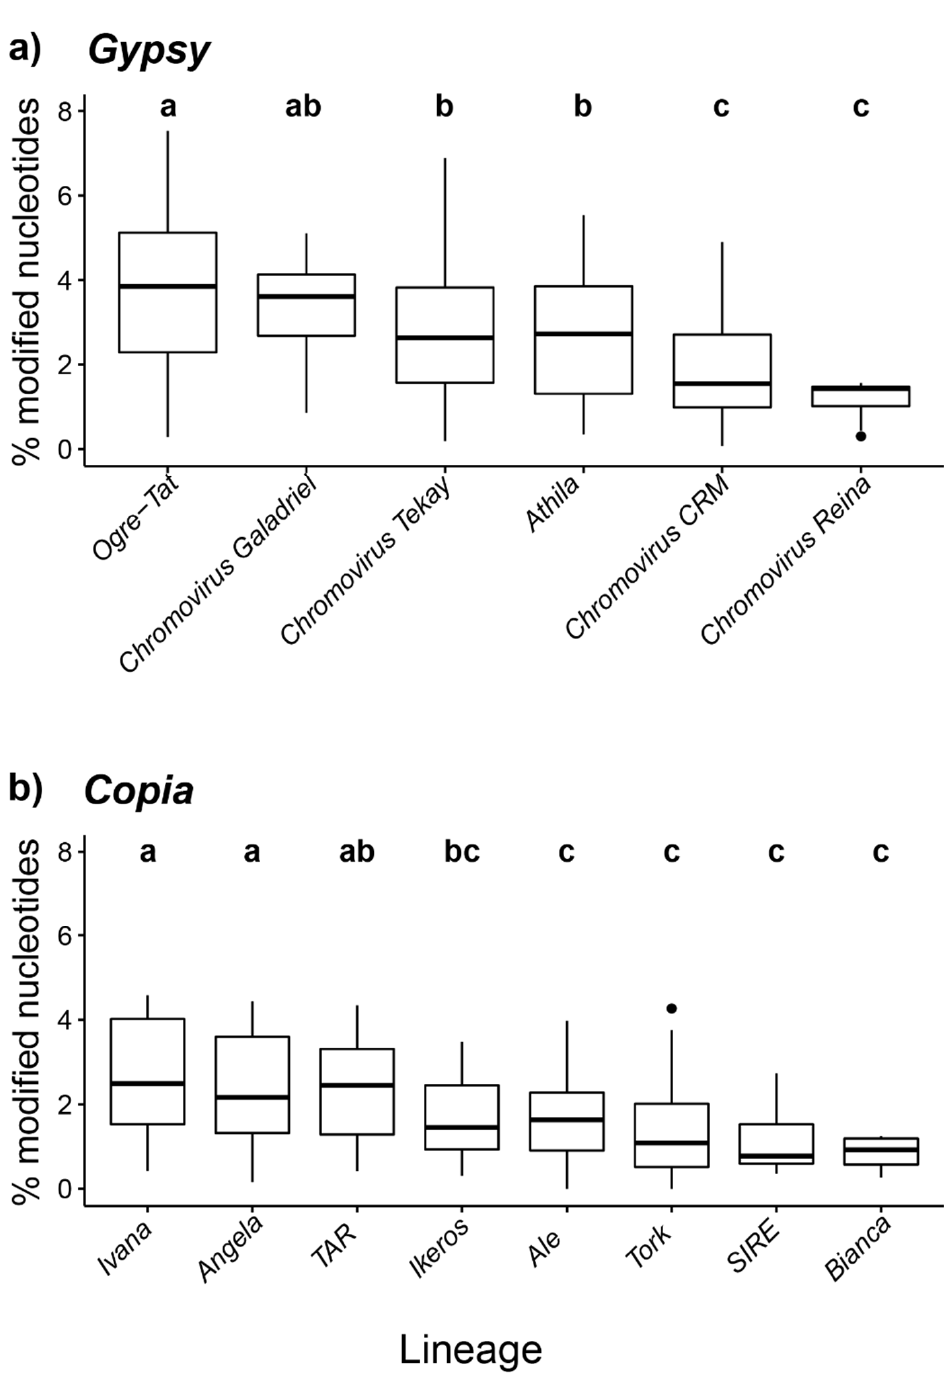
Figure 2. Percentage of modified nucleotides (4mC and 6mA) in fig full-length LTR-REs. The distributions of the percentage of the modified nucleotides are reported across different lineages of full-length Gypsy ( a ) and Copia ( b ) LTR-REs. The letters above each box-plot indicate the significance ranking ( p < 0.05) according to Tukey’s test; the dots represent outlier values.